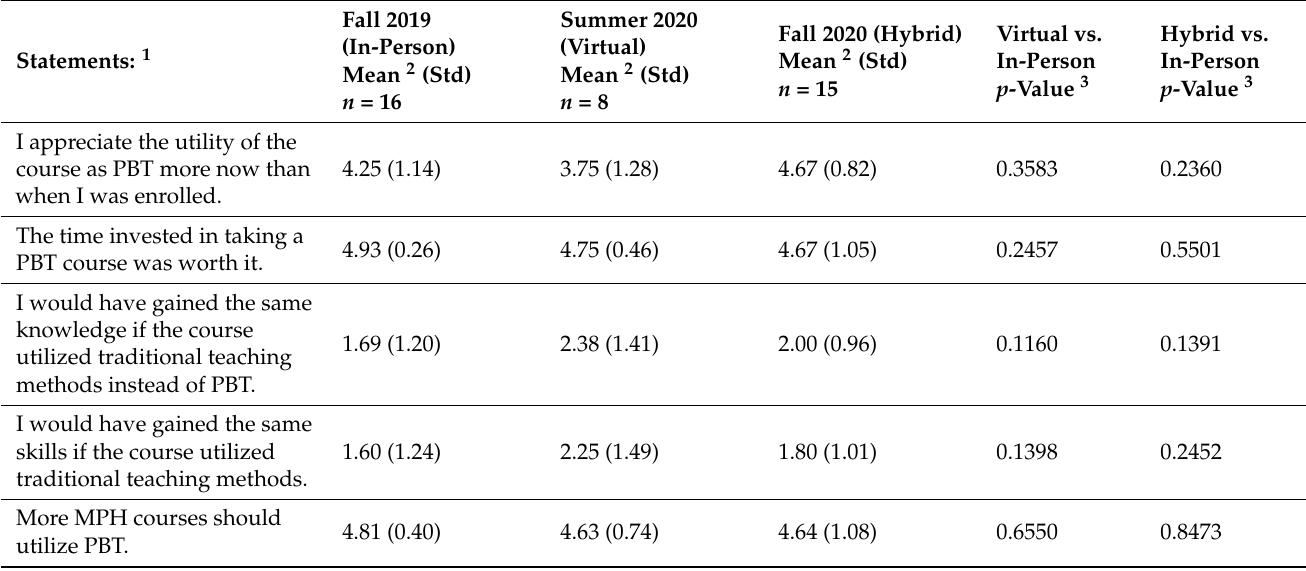
Table 3. Post-Course Student Attitudes and Beliefs of PBT across Three Semesters: In-Person, Virtual, and Hybrid ( n = 39).